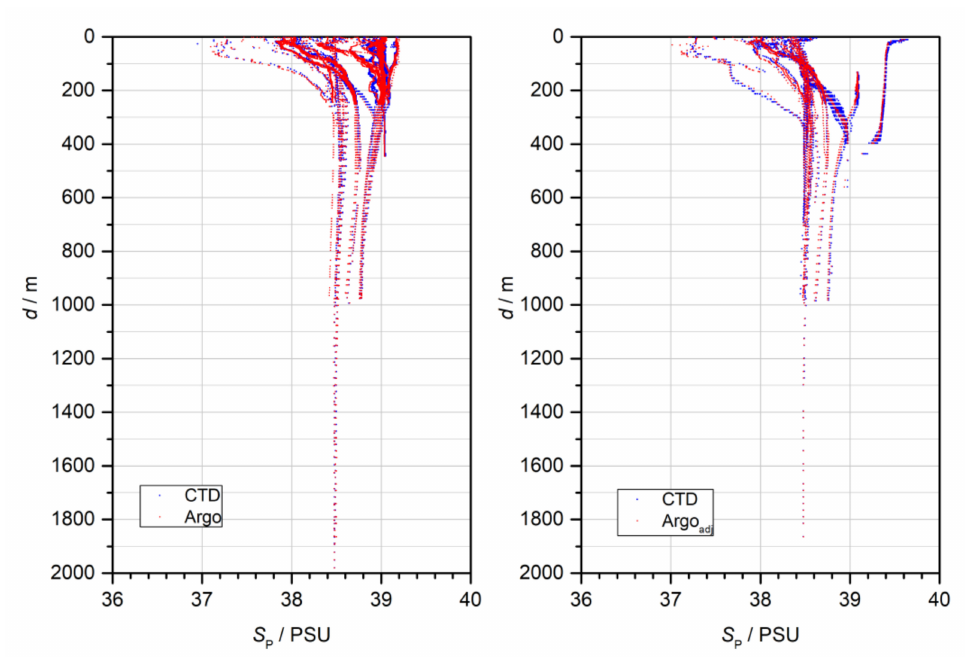
Figure 13. Overall Argo (red dots: not-adjusted, left , and adjusted, right ) and CTD (blue dots) matched salinity